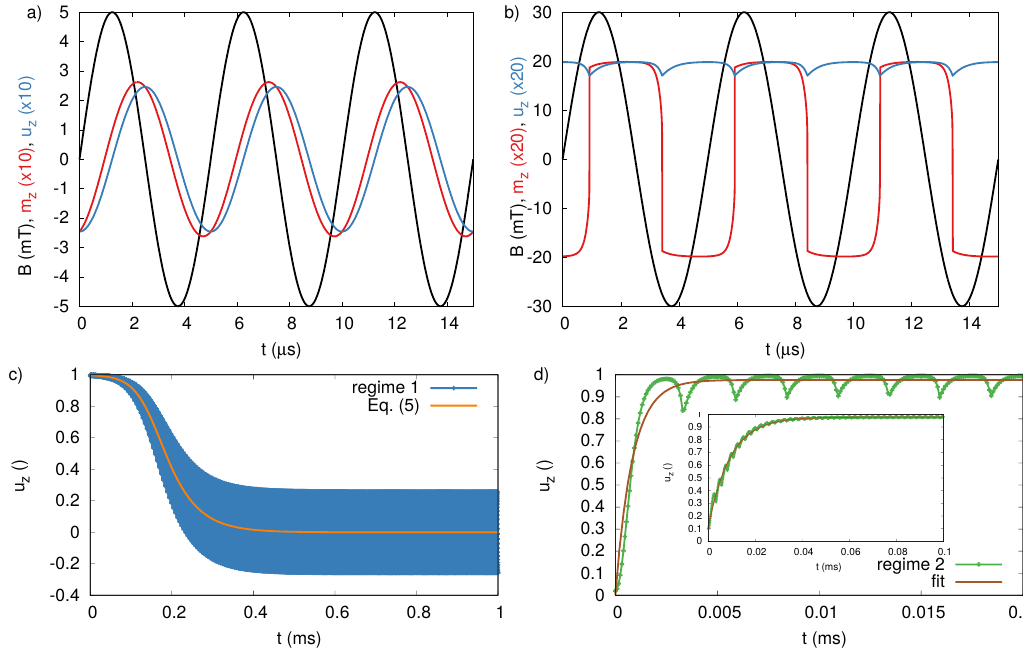
Figure 2. ( a , b ) The magnetic field, B, with frequency f = 200 kHz, and out-of-plane component of the magnetization, m z , and anisotropy, u z , as function of time for a particle with anisotropy field H K = 50mT. The field amplitude is 5 and 30 mT in panel a and b, respectively, corresponding to the 2 different dynamic regimes in which u z is on average equal to 0 or close to 1. ( c , d ) The relaxation of u z towards its dynamical equilibrium value, together with the analytical result of Equation (5) (in regime 1) or the best fit with Equation (7) (in regime 2). Because the dynamic equilibrium is reached very fast for these material parameters, the inset shows a similar result for a particle with H K = 20 mT, excited with a field with amplitude 15 mT, where the validity of the fit (brown line) to Equation (7) is visible over multiple periods of the excitation